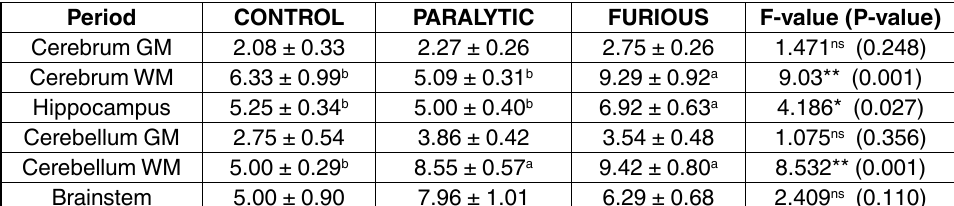
table 2. Comparison of No. of positive cells per unit area in GFAP expression between groups Period cONtROl PaRalYtic